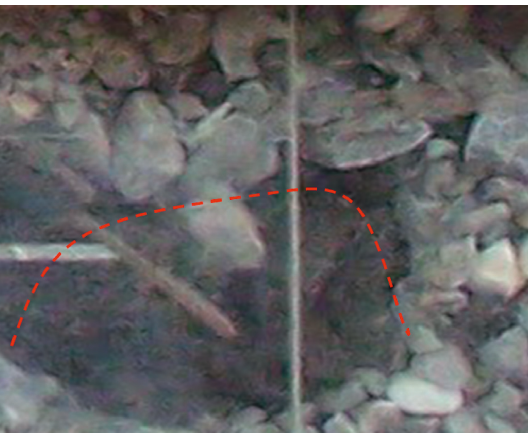
Figure 12: Arch opening.